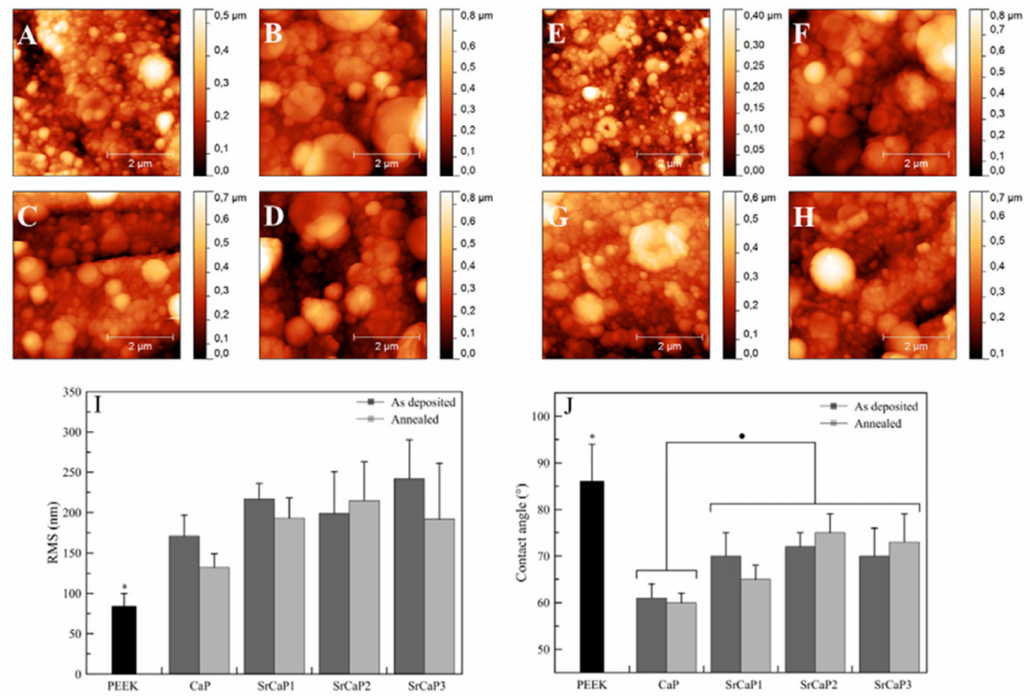
Figure 5. Atomic force microscope (AFM) images of the as-deposited ( A – D ) and annealed ( E – H ) coatings; CaP (Sr 2 + -free coating) ( A , E ), SrCaP1 (Sr / Ca molar ratio = 0.04) ( B , F ), SrCaP2 (Sr / Ca molar ratio = 0.10) ( C , G ), and SrCaP3 (Sr / Ca molar ratio = 0.20) ( D , H ). Root Mean Square (RMS) roughness ( I ) and water contact angle ( J ) of the bare PEEK, as-deposited, and annealed coatings. Reprinted